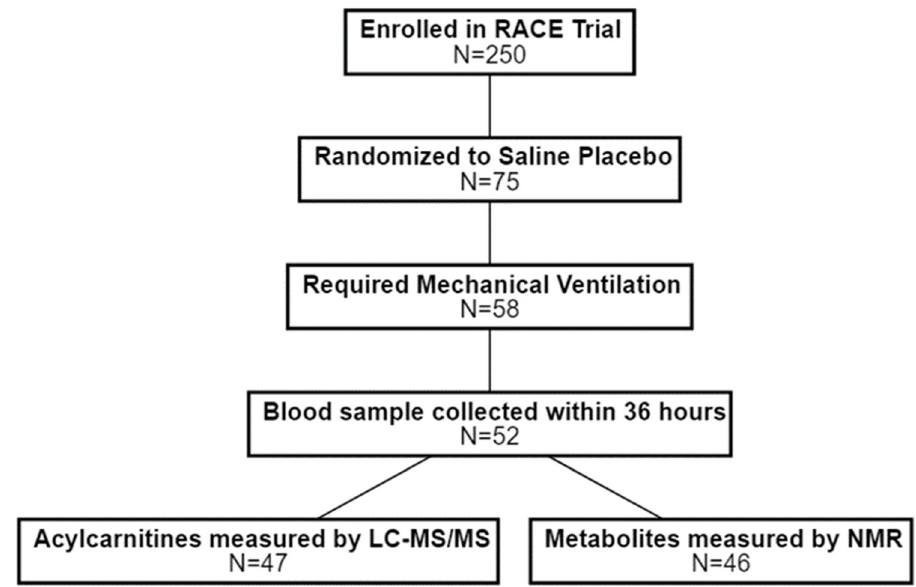
Figure 1. Study flow diagram. Patients were considered for this secondary analysis of the RACE clinical trial if they were randomized to (1) receive saline placebo; (2) required mechanical ventila- tion; and (3) had a blood sample collected within 36 h of the initiation of mechanical ventilation. Metabolomics data were generated and available for a subset of patients. RACE = Rapid Admin- istration of Carnitine in Sepsis; LC-MS/MS = liquid chromatography mass spectrometry; NMR = nuclear magnetic resonance.